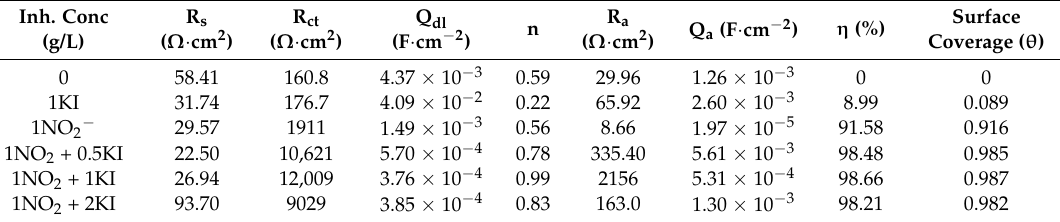
Table 2. Impedance parameters for mild steel in bicarbonate/chloride solution in the absence and presence of different concentrations of KI at 2000 rpm at room temperature.